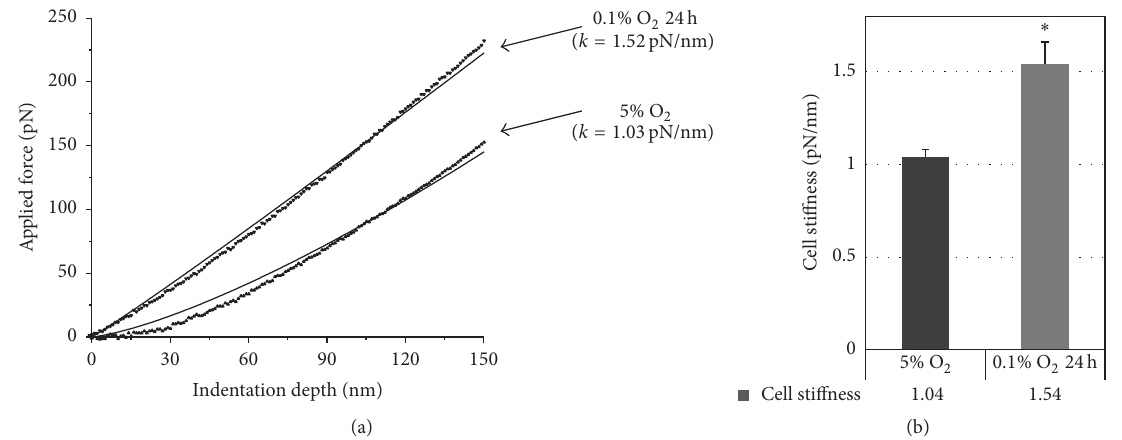
Figure 5: Adipose tissue-derived mesenchymal stromal cells (ASCs) stiffness under physioxia (5% O 2 ) and hypoxic stress (0.1% O 2 , 24 h). (a) Representative force curves, obtained during measurements of cell stiffness. (b) Hypoxic stress increased cell stiffness (mean + standard deviation, ∗ 𝑝 < 0.05 , 𝑛 = 3 ). Seventy cells were analysed in each